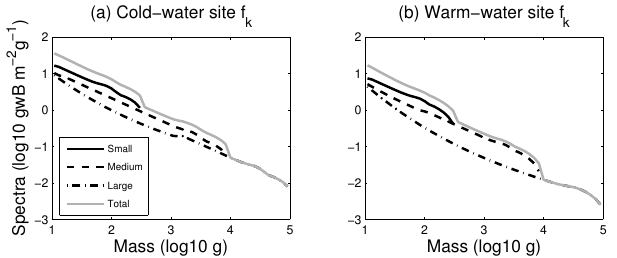
Figure 4. Steady state biomass spectra at two sites. Black solid, dashed, and dash–dot curves represent the small, medium, and large group biomass, respectively, whereas the grey curves represent the total of the three groups. The model is forced at two sites with an- nual average net primary production (NPP) and temperature ( T ) with a timestep of 15 days. Simulations are for a (a) cold-water site in the East Bering Sea LME (64 ◦ N, 165 ◦ W) and a (b) warm-water site in the Benguela Current LME site (20 ◦ S, 12 ◦